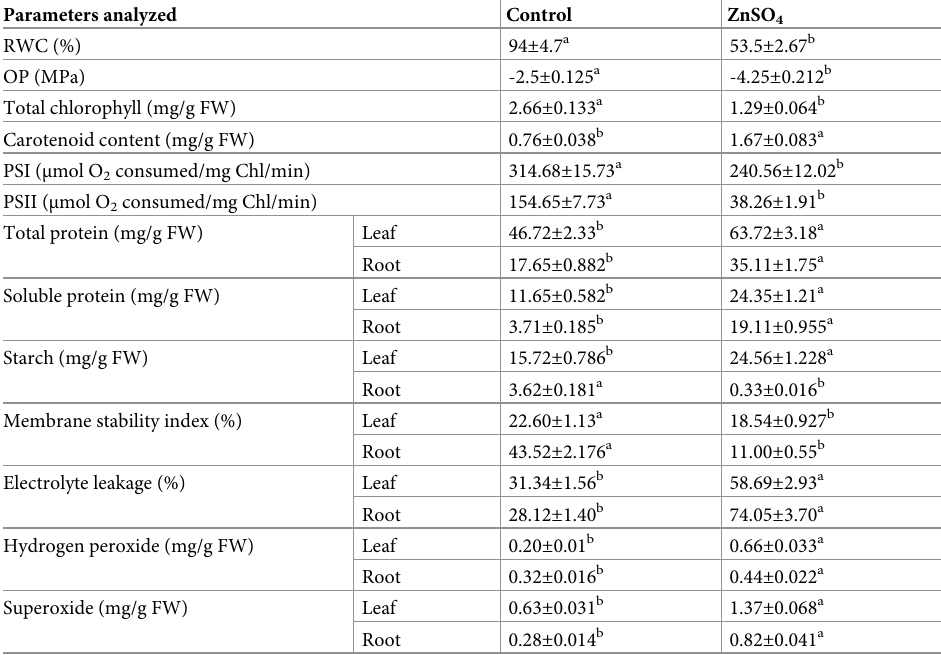
Table 1. Data of the physiological parameters in the roots and leaves of Acanthus ilicifolius L. cultured in Hoag- land solution (control) and exposed to 4 mM ZnSO 4 (treatment). Parameters